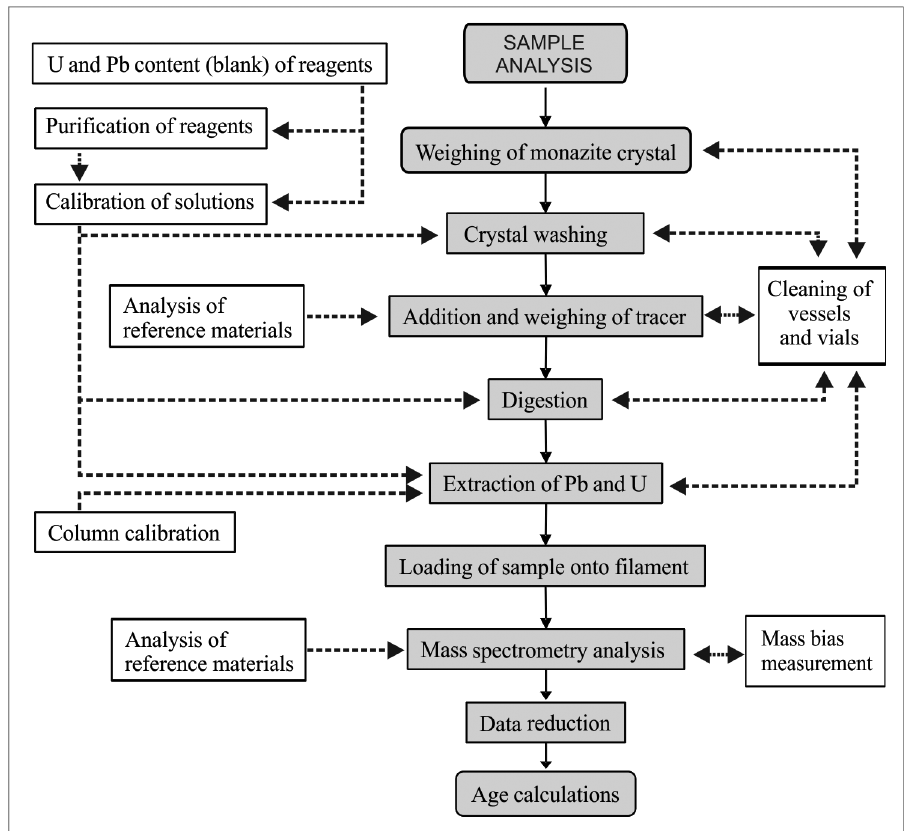
Figure 1 - Laboratory procedures in U-Pb ID-TIMS geochronology. White boxes display side procedures not directly involved in sample analysis (grey